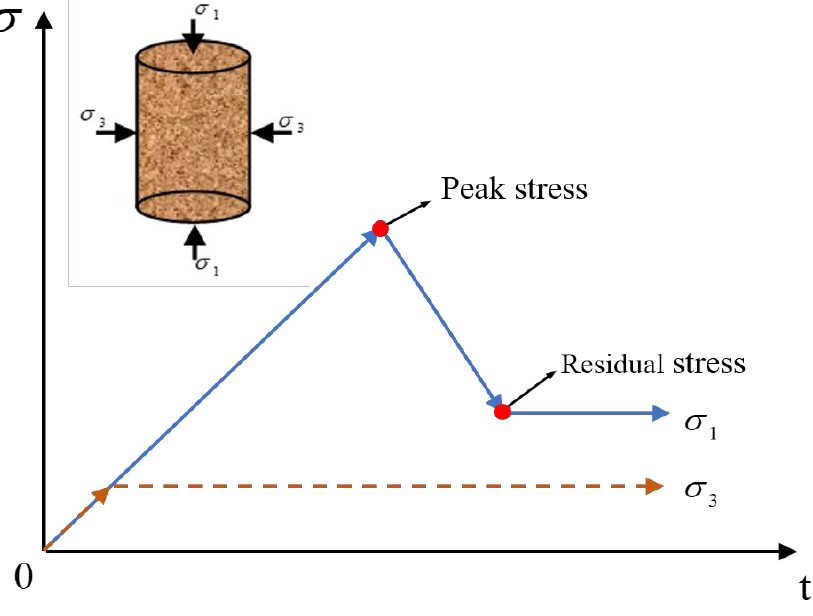
Figure 4. Loading path of CTC tests.